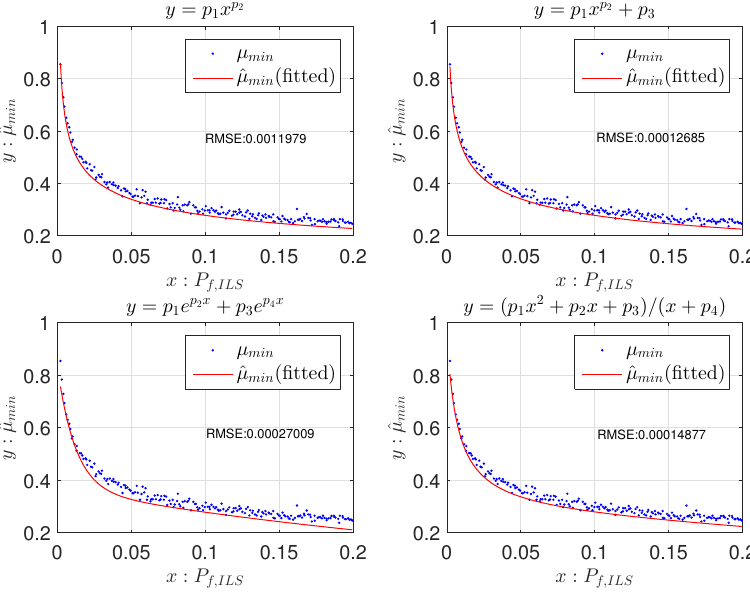
Figure 3. The 95% lower boundary of fitting function candidates of µ min against P f , ILS and the RMSE (see Equation (11)). The tolerable failure rate P tol this example.